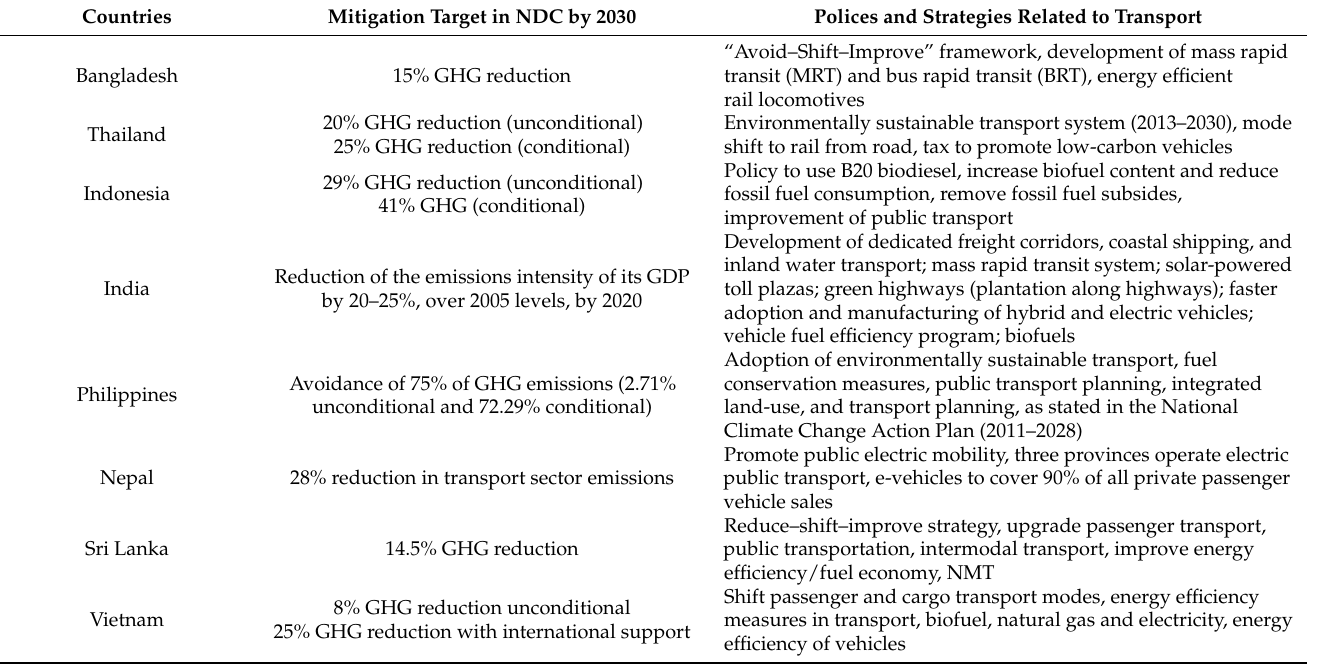
Table 3. Mitigation targets and transport mitigation strategies in selected